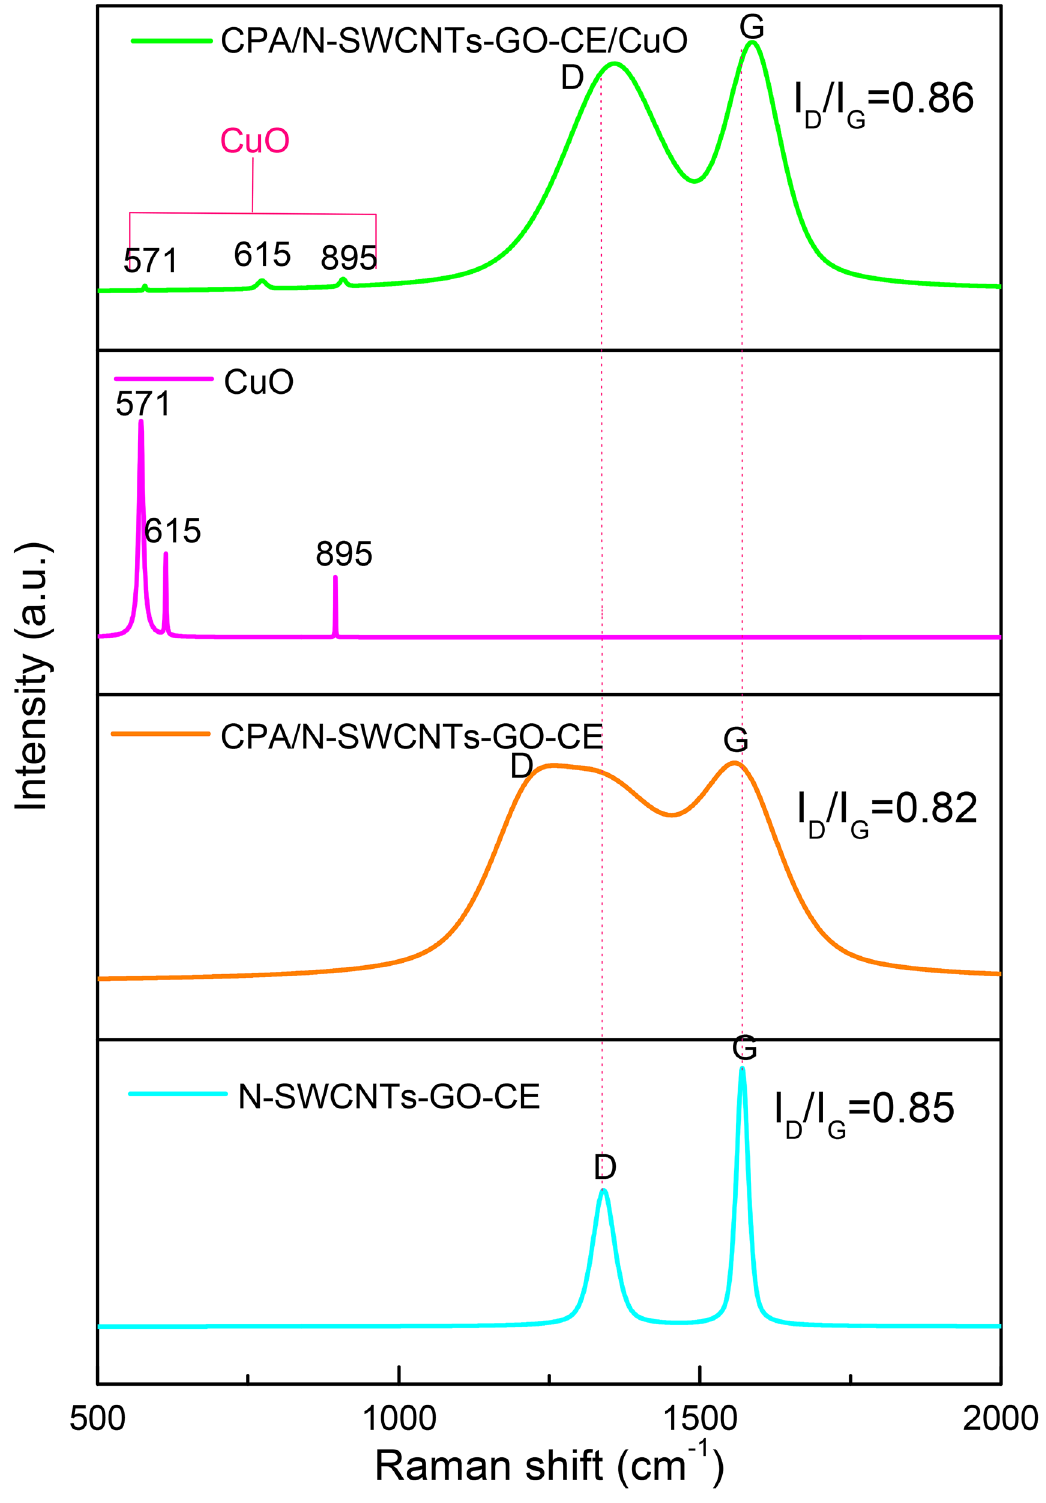
Figure 7. Raman spectrum of N-SWCNTs-GO-CE, CPA/N-SWCNTs-GO-CE, CuO and CPA/N-SWCNTs-